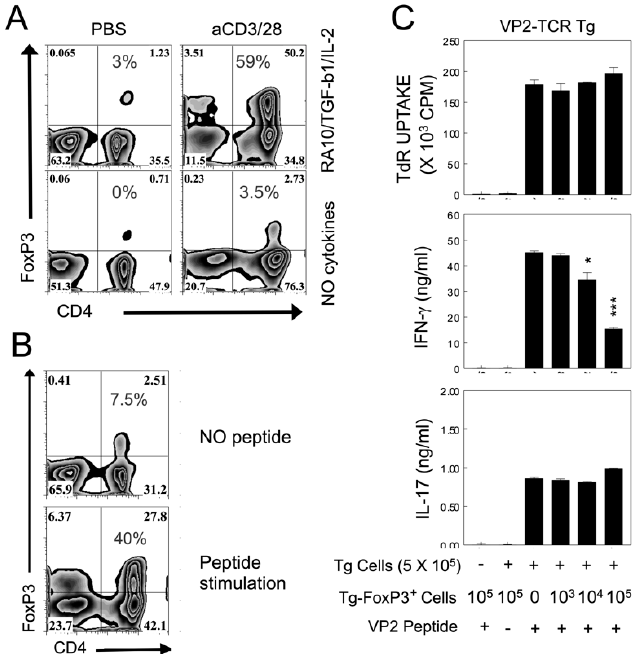
Figure 6. Role of VP2 72-86 specific FoxP3 + CD4 + T cells in the regulation of T cell cytokine production. ( A ) In vitro generation of FoxP3 + CD4 + T cells in the presence or absence of T cell stimulants and/or added cytokines (10 nM retinoic acid, TGF- β , IL-2). Purified VP2 transgenic CD4 + T cells were activated with 1 µg/mL anti-CD28 and 10 µg/mL anti-CD3 plate-bound antibody in the presence of 20 ng/mL rhTGF- β 1 100 U rhIL-2 for 4 d. ( B ) In vitro generation of VP2-specific FoxP3 + CD4 + T cells in the presence or absence of VP2 72-86 peptide in the presence of the above retinoic acid and cytokine mixture. ( C ) The function of VP2-TCR-Tg FoxP3 + CD4 + T cells (10 3 –10 5 ) activated in vitro was assessed with the inhibition of cytokine production of VP2-TCR Tg CD4 + T cells (5 × 10 5 ) upon stimulation with the epitope peptide (VP2 72-86 ). The VP2-TCR-Tg FoxP3 + CD4 + T cells were purified from the spleens of FoxP3/GFP-Tg SJL mice crossed to VP2-TCR-Tg SJL mice for in vitro activation. The in vitro activated FoxP3 + CD4 + T cells for 4 d were further sorted for GFP + Tregs using MoFlo (Dako Cytomation, Glostrup, Denmark). * p < 0.05 and *** p < 0.0001. +, presence and -, absence of peptide.